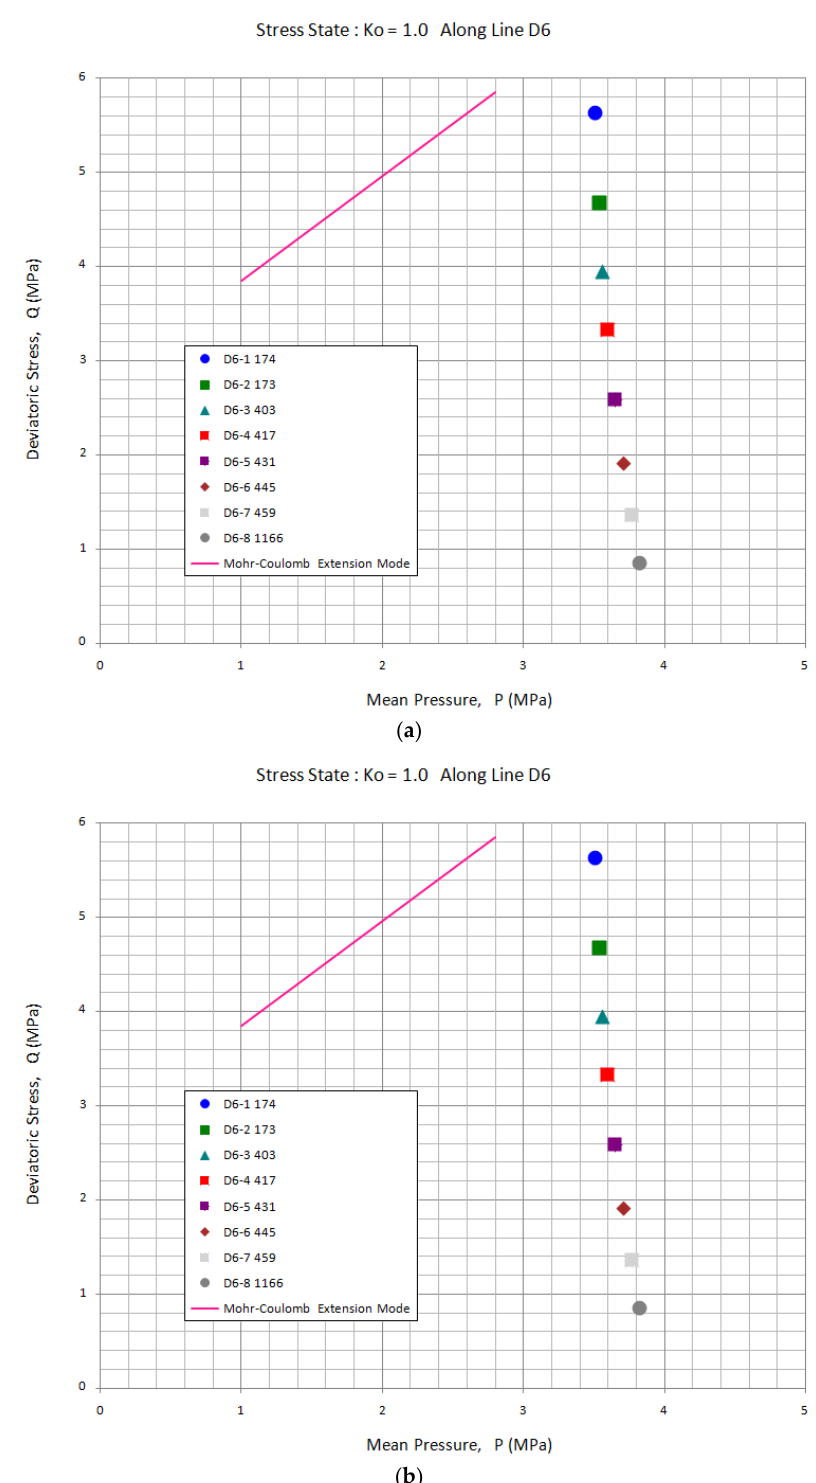
Figure 13 . Stress state (Ko = 1.0): ( a ) Line C5; ( b ) Line D6. Figure 13. Stress state (Ko = 1.0): ( a ) Line C5; ( b ) Line